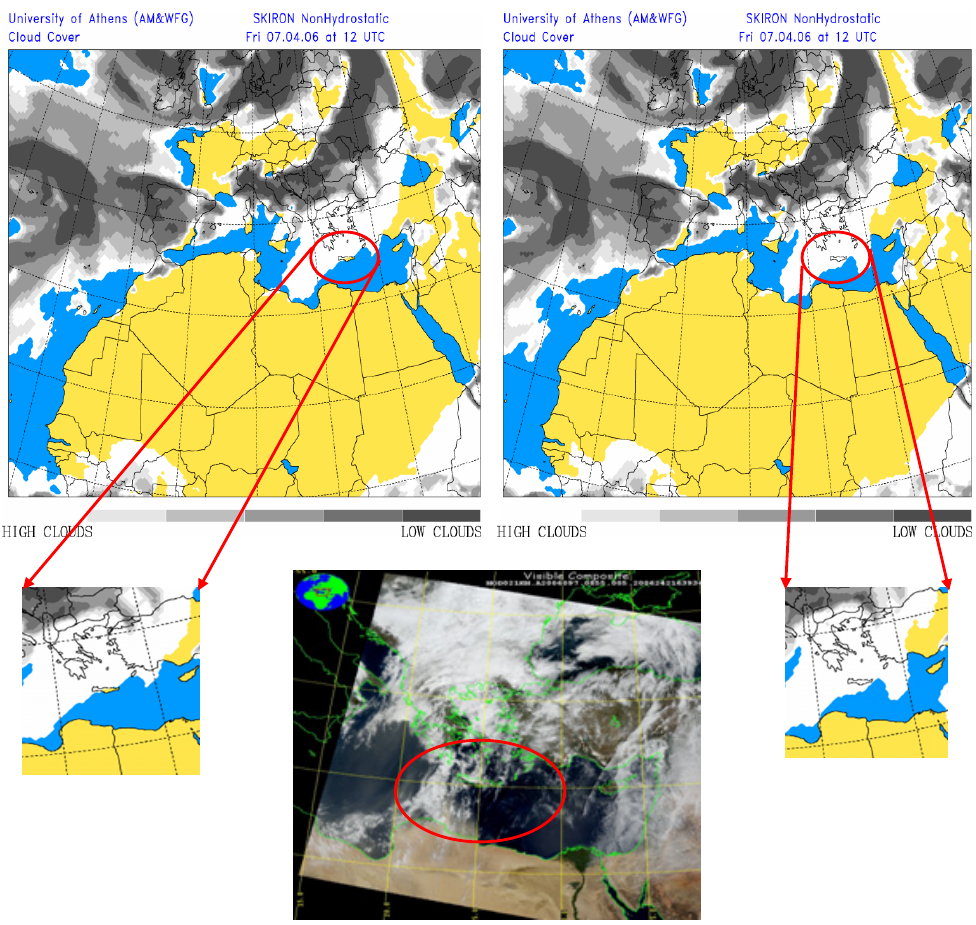
Fig. 5. Cloud cover distribution over the simulation domain on 7 April 2006 at 12:00UTC for both model setups: in the left panel the NDE simulation and in the right panel the WDE simulation. In the bottom panel the actual cloud formations from the MODIS satellite are